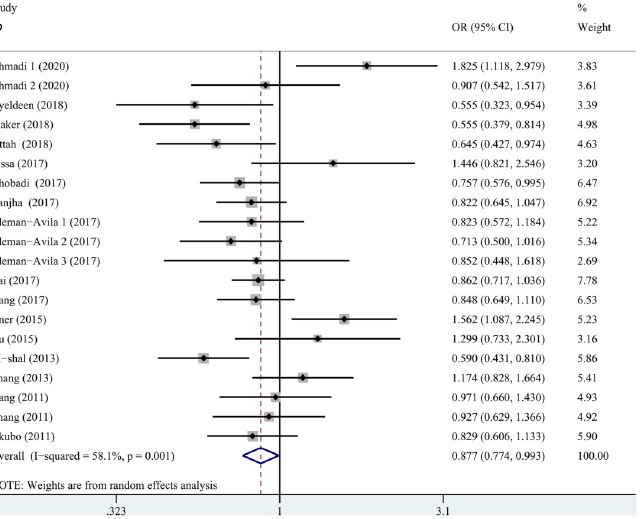
Fig 2. Meta-analysis of the association of the miRNA-499 rs3746444 polymorphisms with the autoimmune diseases (T vs. C).